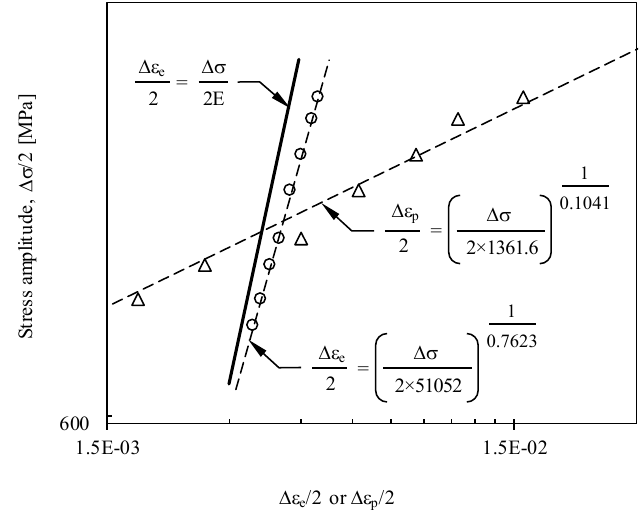
Figure 9. Relation between the cyclic stress amplitude and elastic and plastic strain amplitudes for the stable hysteresis loops.